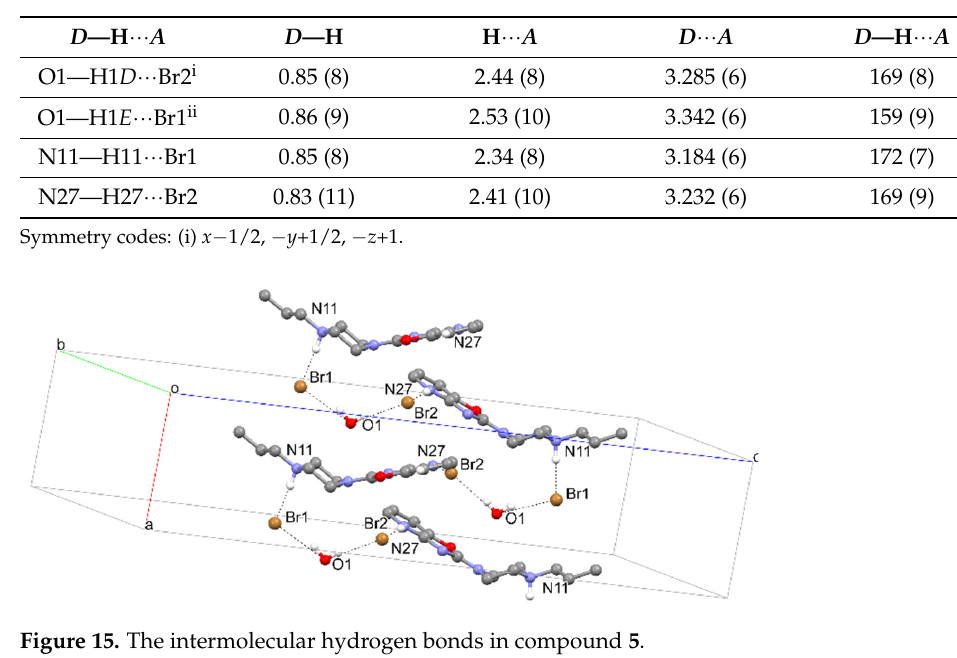
Figure 14. The crystal packing of 5 . Table 6. Strong hydrogen-bond geometry (Å, º) for 5 .